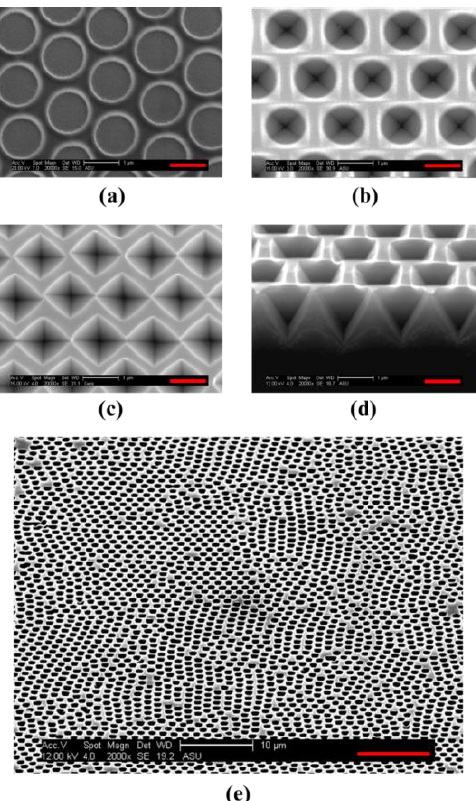
Figure 6. SEM images of ( a ) SS removed Cr mask layer deposited Si surface, ( b ) 1% KOH etched Si surface with Cr mask layer, ( c ) inverted Si pyramid without Cr mask layer, ( d ) cross-sectional image of inverted Si pyramid, and ( e ) fabricated inverted pyramids over large surface area to show its uniformity (Inverted pyramid has ~10% size variation likely caused by an initial SS size variation of 10%.). Note: ( a – d ) scale-bar = 1 μm, and ( e ) scale-bar = 10 μm.